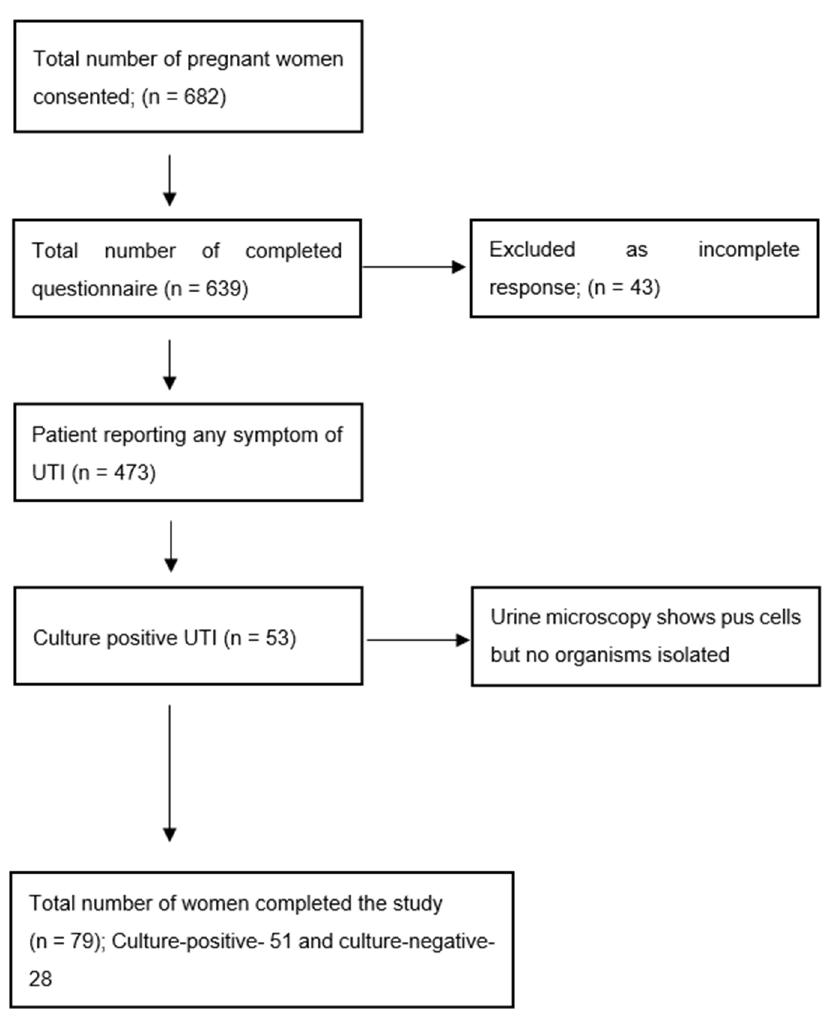
Figure 1. Patient